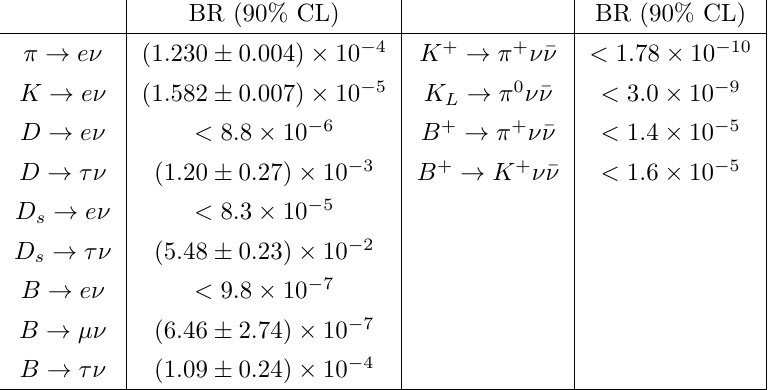
Table 14 . Charged current and neutrino processes sensitive to CLFV operators. All limits are taken from ref. [57], with the exception of K + → π + ν ¯ ν , for which we use the more recent result in ref.